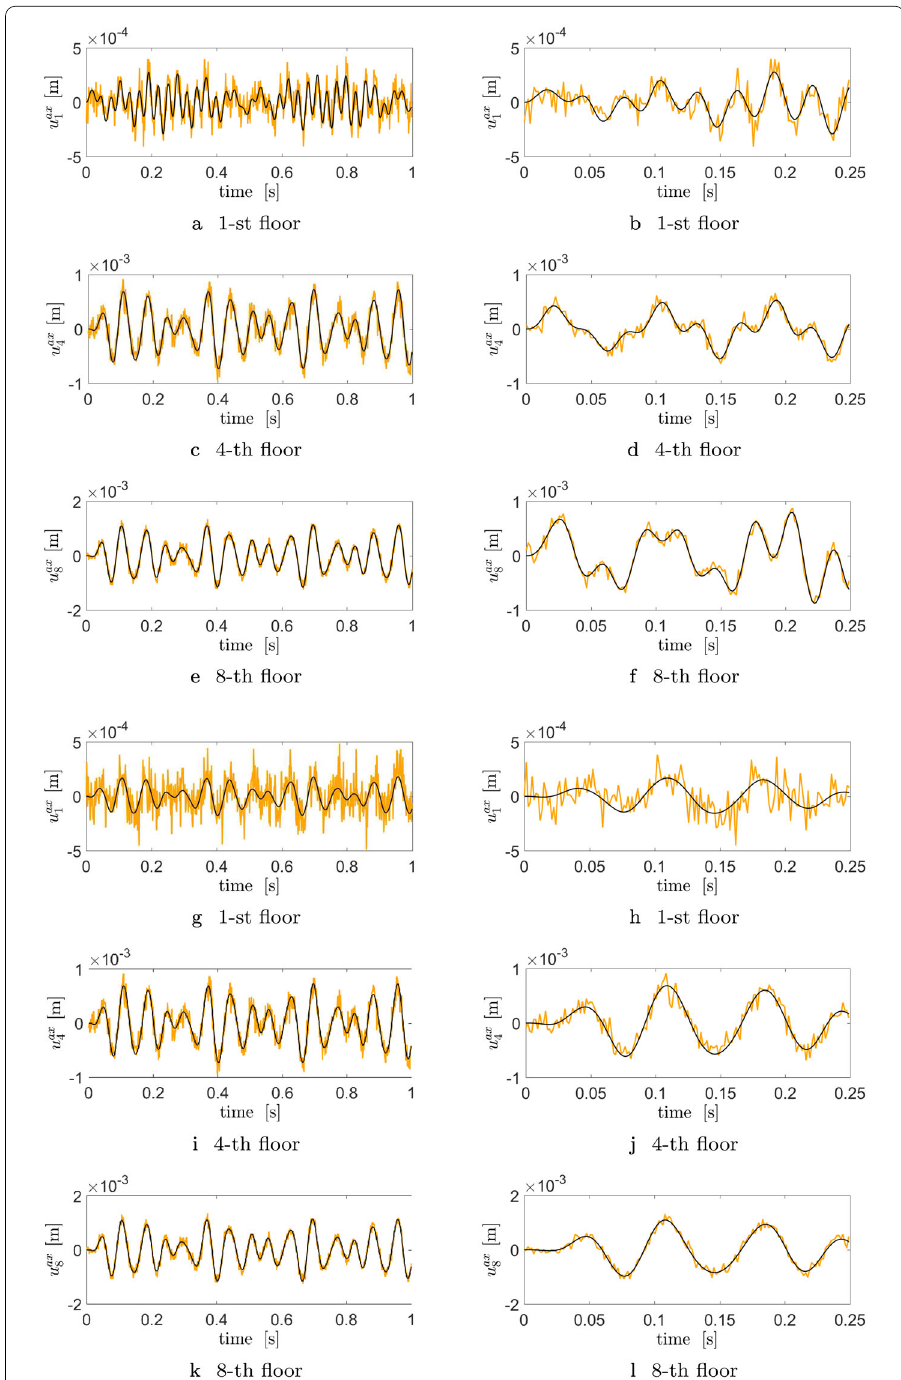
Fig. 8 Example of time evolutions of z displacements for stories 1 , 4 , 8 with SNR = 15 dB (from a – f ) and = ( 32 . 8 , 28 . 2 ) , γ ax = ( 1 . 38 , 1 . 38 ) . High-noise SNR = 10 dB (from g – l ), undamaged state. Low-noise case: f ax 1 , 2 1 , 2 = (15 . 5 , 22 . 0), γ ax = (1 . 133 , − 1 . 140). Orange lines represent u , whereas black lines stand for r , case: f ax 1 , 2 1 , 2 according to Eq. (2). On the right side, a closer view for each left side plot is